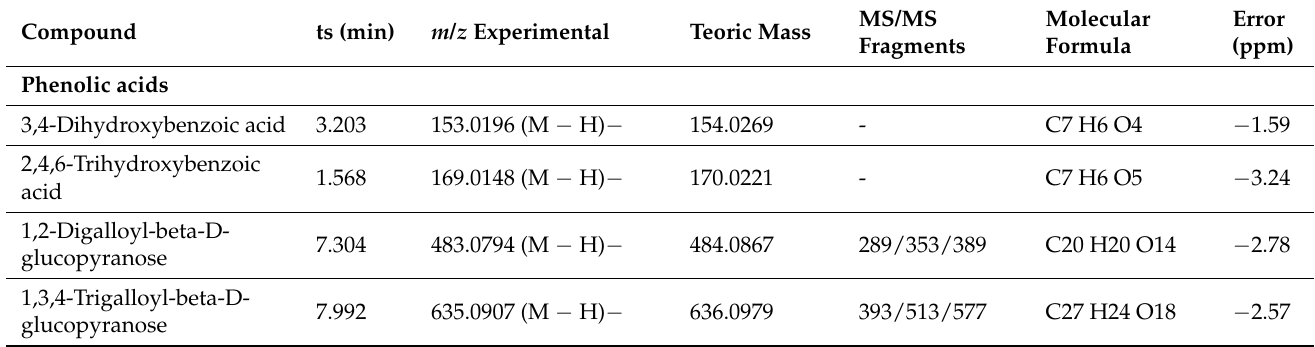
Table 6. Phytochemical profile of the 60% methanolic extract of A. angustiloba leaves by LC–MS in